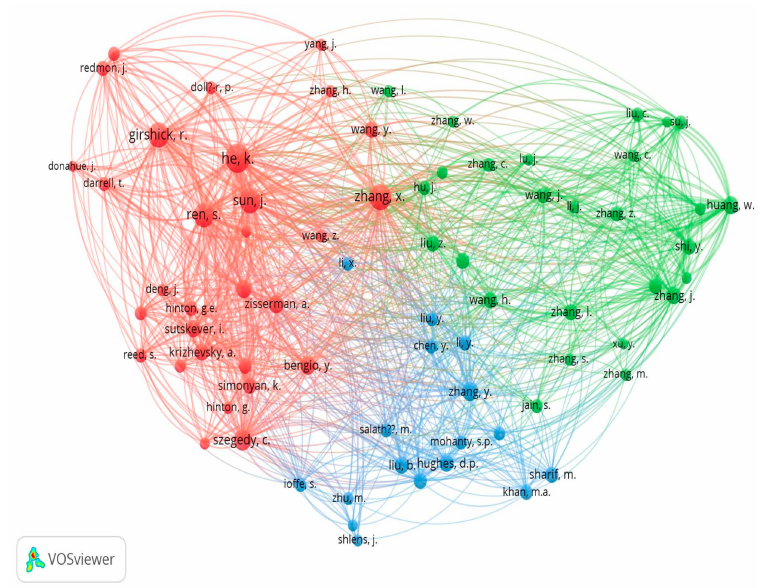
Figure 28. Author Wise Co-citation Network (Source: https://www.vosviewer.com (accessed on 14 September